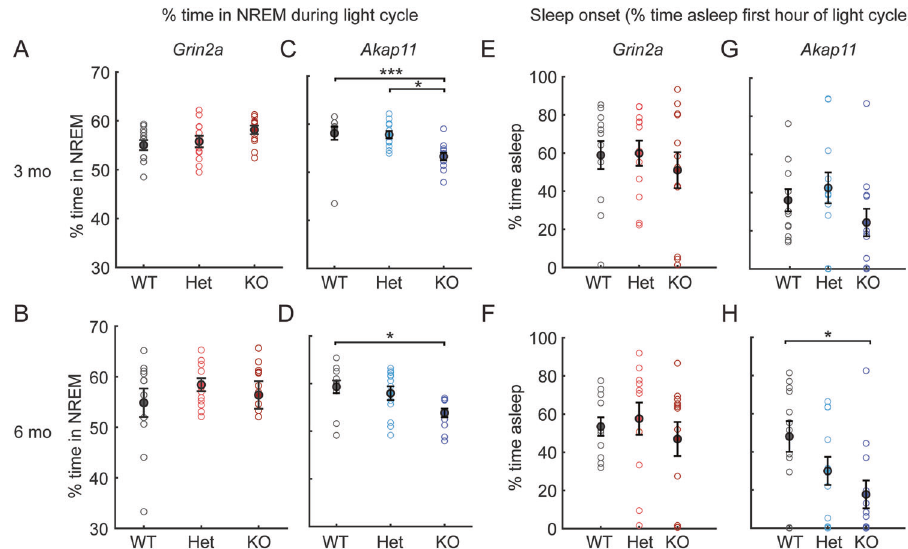
Fig. 2 NREM sleep and sleep onset time of Grin2a and Akap11 mutant mice. A – D % of time spent in NREM sleep during the light cycle in 3- and 6-month Grin2a and Akap11 mutants. E – H Sleep onset, as quanti fi ed by the % of time spent asleep in the fi rst hour of the light cycle. Error bars denote mean ± standard error; p < 0.05, ** p < 0.01, *** p < 0.001; n = 11 – 12